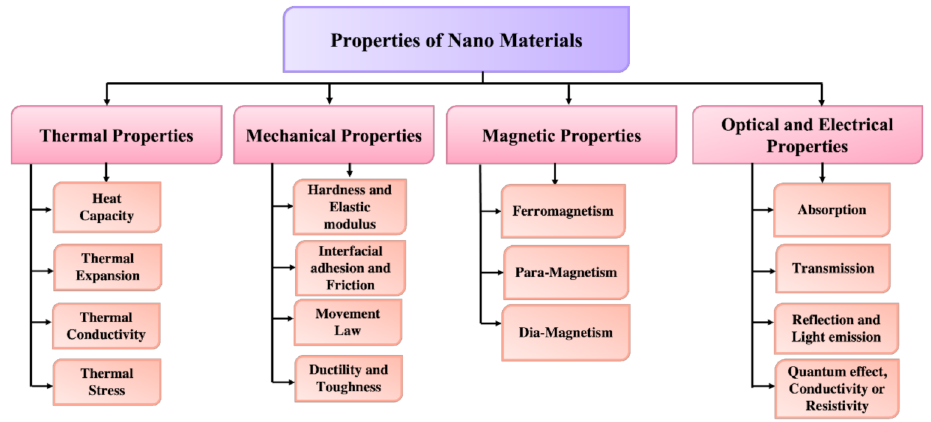
Figure 7. Classifications of nanomaterials based on their physical and chemical